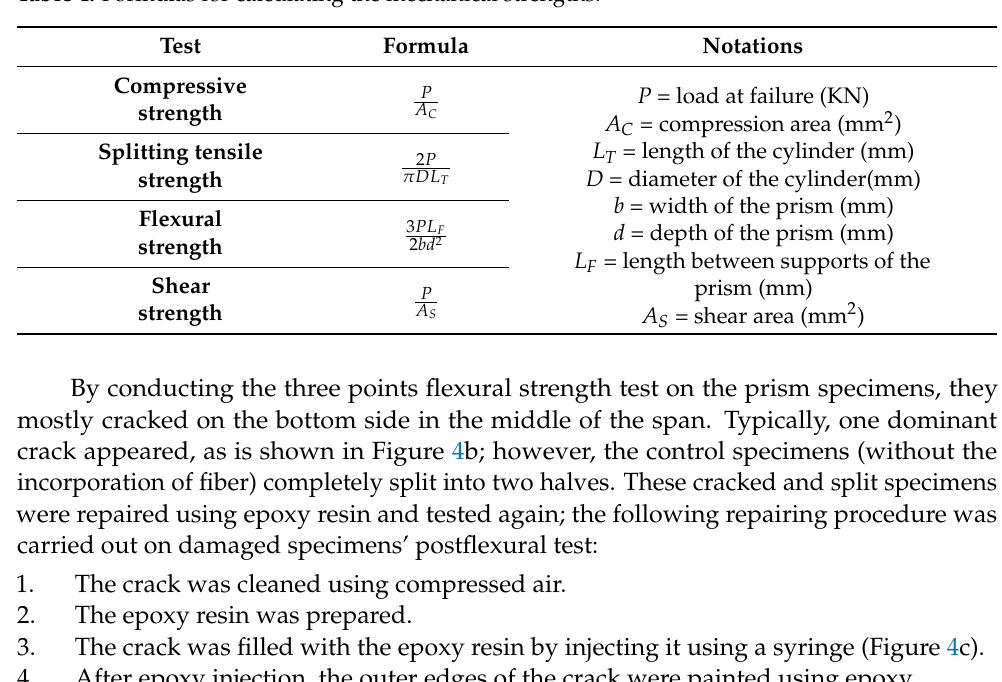
Figure 3. Cylindrical push-off specimen. Figure 3. cylindrical push-off specimen. Table 4. Formulas for calculating the mechanical strengths. Table 4. Formulas for calculating the mechanical